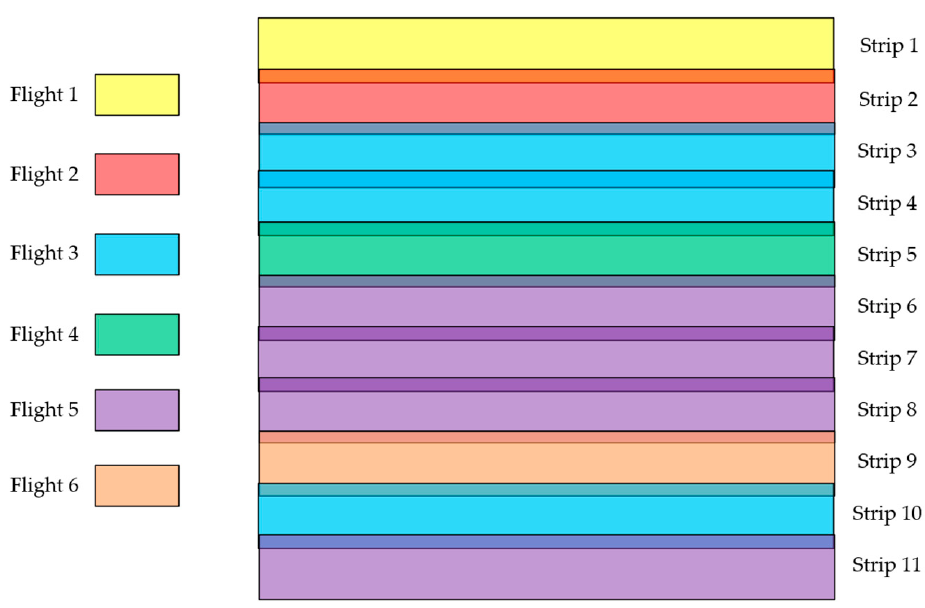
Figure 19. Distribution of 11 adjacent strips of 6 different sorties. In order to evaluate the elevation accuracy, this experiment selects the points with corner reflector characteristics and flat surrounding ground as the marking points according to the SAR image of this area. The marking point is used as the control point to obtain the interferometric calibration parameters, and then the elevation inversion and elevation accuracy inspection are completed. Therefore, the comparison of results in this section is based on the elevation data of marking points. The algorithm in this paper is used to extract the tie-points between different sorties, and to conduct interferometric calibration based on tie-points and elevation inversion. Table 2 shows the comparison between the error parameters obtained based on the interferometric calibration of tie-points and marking points. In Table 2, it is assumed that the calibration parameters and elevation data of strip 1 of the first flight are known, and the parameters of the remaining 10 strips are obtained through interferometric